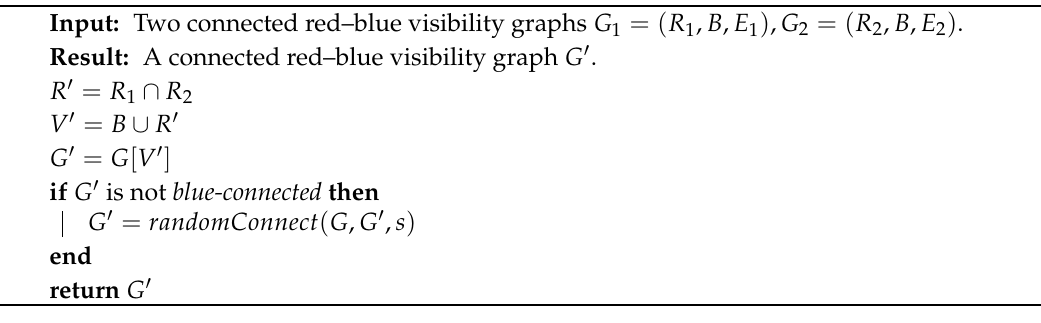
Algorithm 5: Pseudocode of the crossover operator.